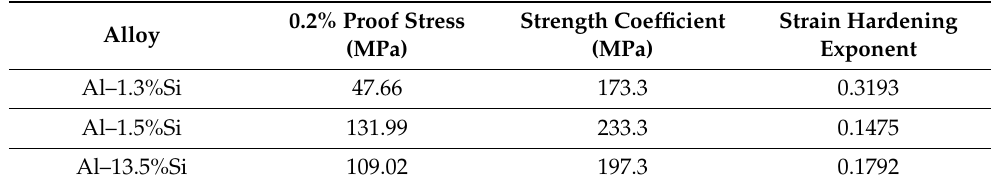
Figure 6. ( a ) True stress-strain and ( b ) log stress-log strain curves obtained from compression test for all examined alloys. Table 3. Mechanical behavior parameters (strength coefficient and strain hardening exponent) of the examined